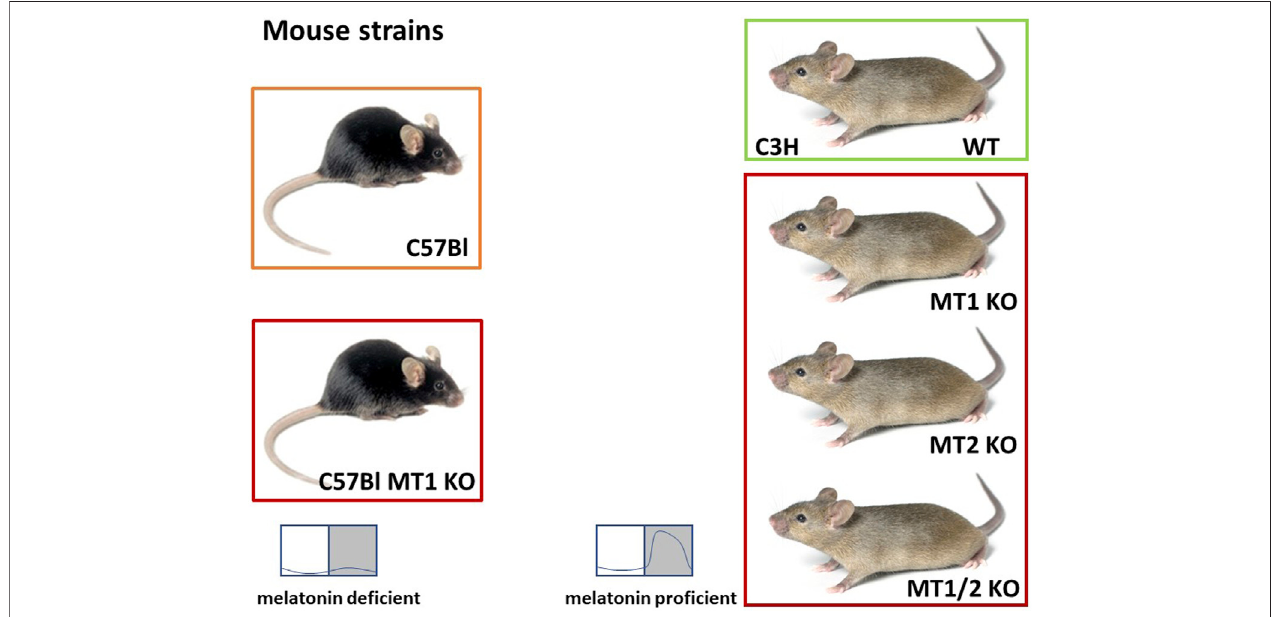
FIGURE 2 | Overview of the mouse models used to elucidate the role of melatonin and the melatonin receptors (MT1/2). The C57Black/6J (C57Bl) mice are melatonin de fi cient. C57Bl mice with a targeted deletion of the MT1 gene (C57Bl MT1 KO; Liu et al., 1997) were initially used for experiments elucidating the role of externally applied melatonin. C3H/HeN (C3H) mice are melatonin-pro fi cient, but visually blind. C3H mice with a targeted deletion of the MT1 receptor (C3H MT1 KO) or the MT2 receptor (C3H MT2 KO) were obtained by breeding the initial melatonin receptor KO mice (Liu et al., 1997; Jinet al., 2003) on a melatonin-pro fi cient C3H/ HeNbackgroundforatleast10generations.C3Hdoublemelatoninreceptorde fi cientmice(C3HMT1/2KO)wereobtainedbycrossingC3HMT1KOandC3HMT2KO mice and breeding the MT1/2 KO offspring for at least 10 generations. These animals are used to investigate the role of endogenous melatonin and the role of the melatonin receptors (C3H and C57Bl mouse: